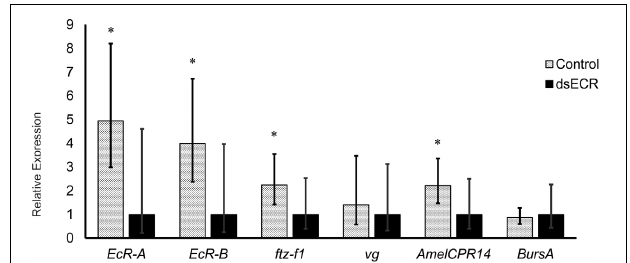
FIGURE 4 | Relative transcript levels of four candidate EcR-target genes following EcR knockdown in honeybee workers. Twelve pharate-adult workers (Pbl phase) were injected with 5 μ g of EcR-dsRNA (KD) or GFP-dsRNA (C, control) and sampled just after adult eclosion. Bars represent means and S.E.M of 12 biological replicates, each run as three technical replicates. ∗ Indicates a statistically significant difference (Mann–Whitney Test, P ≤ 0 .